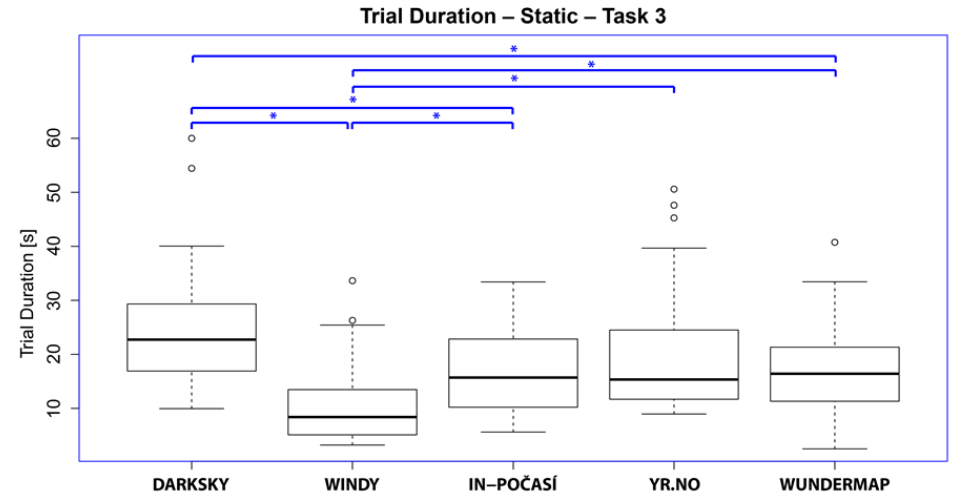
Figure 17. Trial Duration in the Static Section—Task